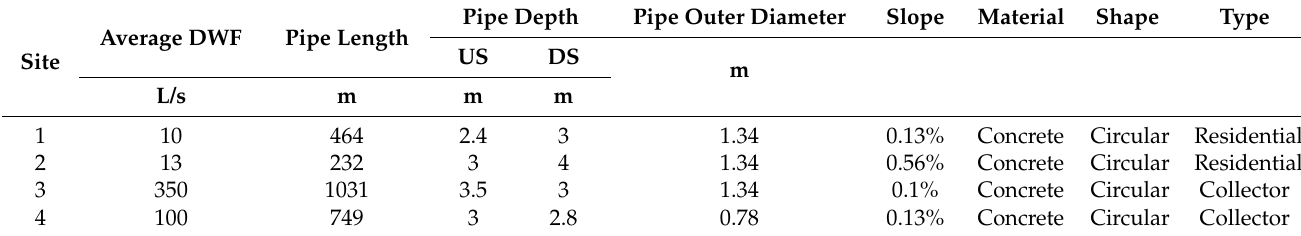
Table 1. Details of sewer pipes used for data